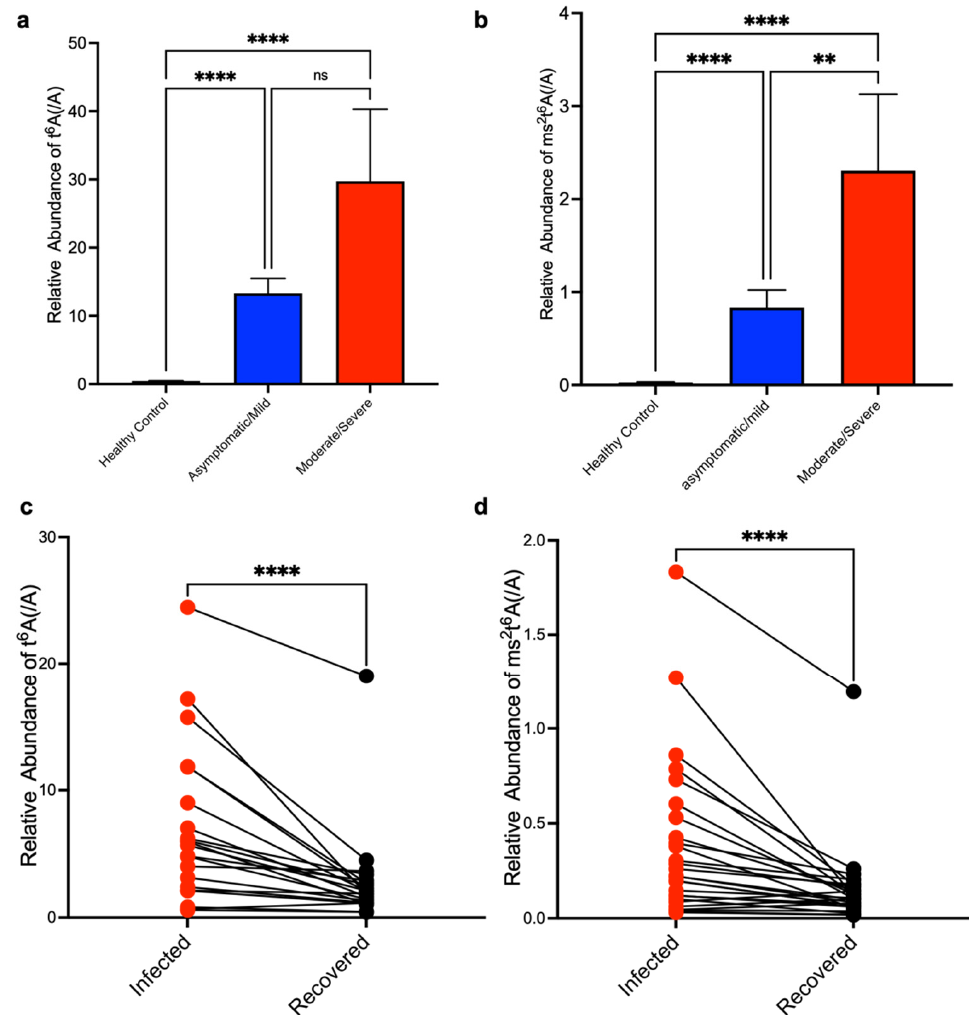
Figure 5. Elevations of t 6 A and ms 2 t 6 A in serum of COVID-19 patients correlate with severity and recovery of COVID-19. ( a , b ) Elevation of t 6 A ( a ) and ms 2 t 6 A ( b ) in serum categorized by COVID-19 severity. LC-MS peak areas of t 6 A or ms 2 t 6 A divided by LC-MS peak areas of adenosine are shown. ** p < 0.01, **** p < 0.0001 by Kruskal–Wallis test and Dunn’s multiple comparison test. ( c , d ) Comparison of t 6 A ( c ) and ms 2 t 6 A (d) levels in serum of COVID-19 patients at the time of infection and recovery. A recovery period was defined by the resolution of fever and other symptoms. LC-MS peak areas of t 6 A or ms 2 t 6 A divided by LC-MS peak areas of adenosine are shown. **** p < 0.0001 by Wilcoxon rank-sum test.